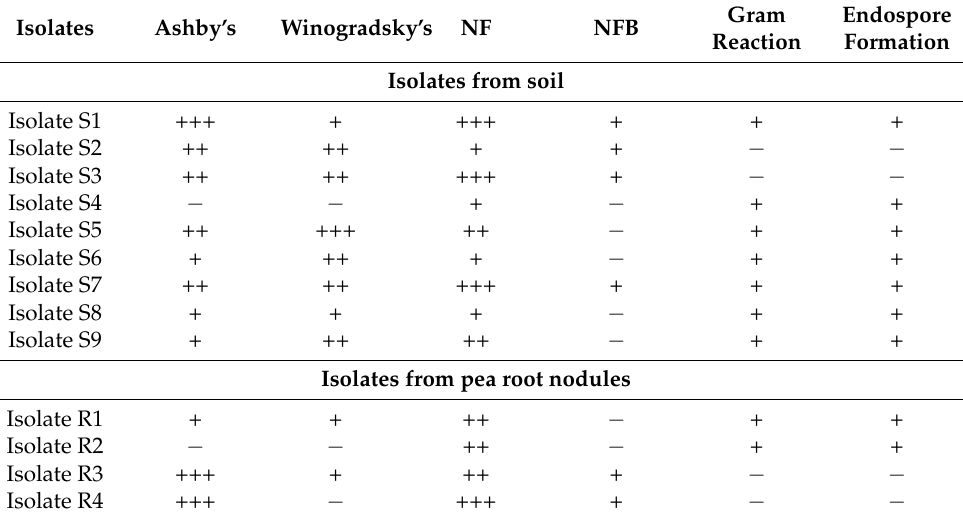
Table 2. Growth of isolates in semi-selective media, no growth ( − ), weak growth (+), medium growth (++), and intensive growth